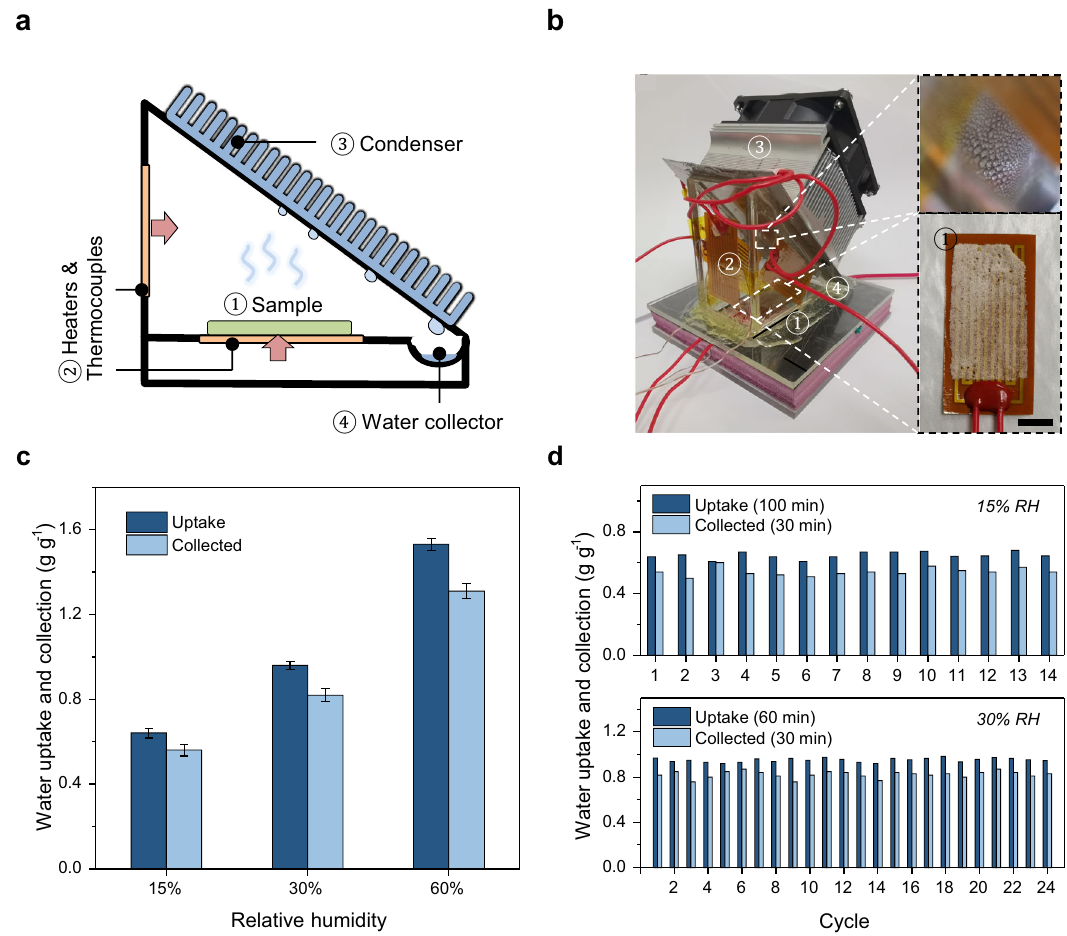
Fig. 4 Water collection and stable cycling performance of SHPF. a Design scheme and b a photograph of the water collection device. Inset: photographs of condensed water droplets (top) and zoom-in sample (bottom). Scale bar: 1 cm. c Water uptake and collected water at different relative humidity. d Cycling performance of SHPF at 15% and 30%